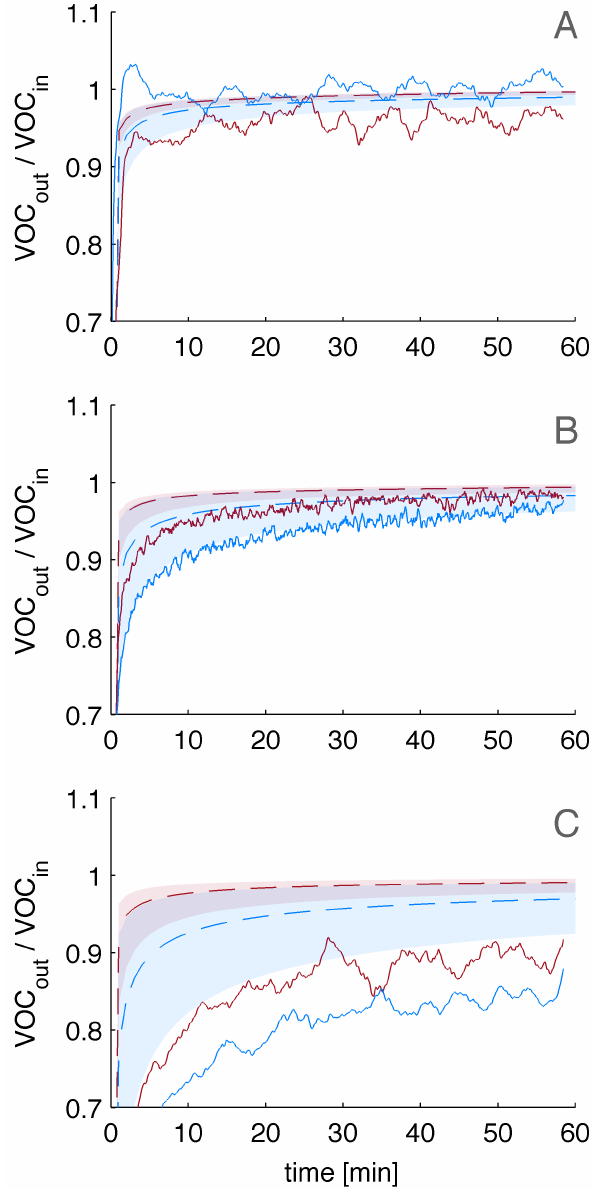
Fig. 3. Experimental recovery profiles (solid lines) of methanol (blue) and acetone (red) at different temperatures ( (A) 263K, (B) 243K, (C) 223K) in snow-maker snow. Also shown are results from numerical simulations of the recovery (dashed line) with uncertain- ties (shaded area), where the air–water partitioning (Henry’s law coefficient) was used to parameterize the effective